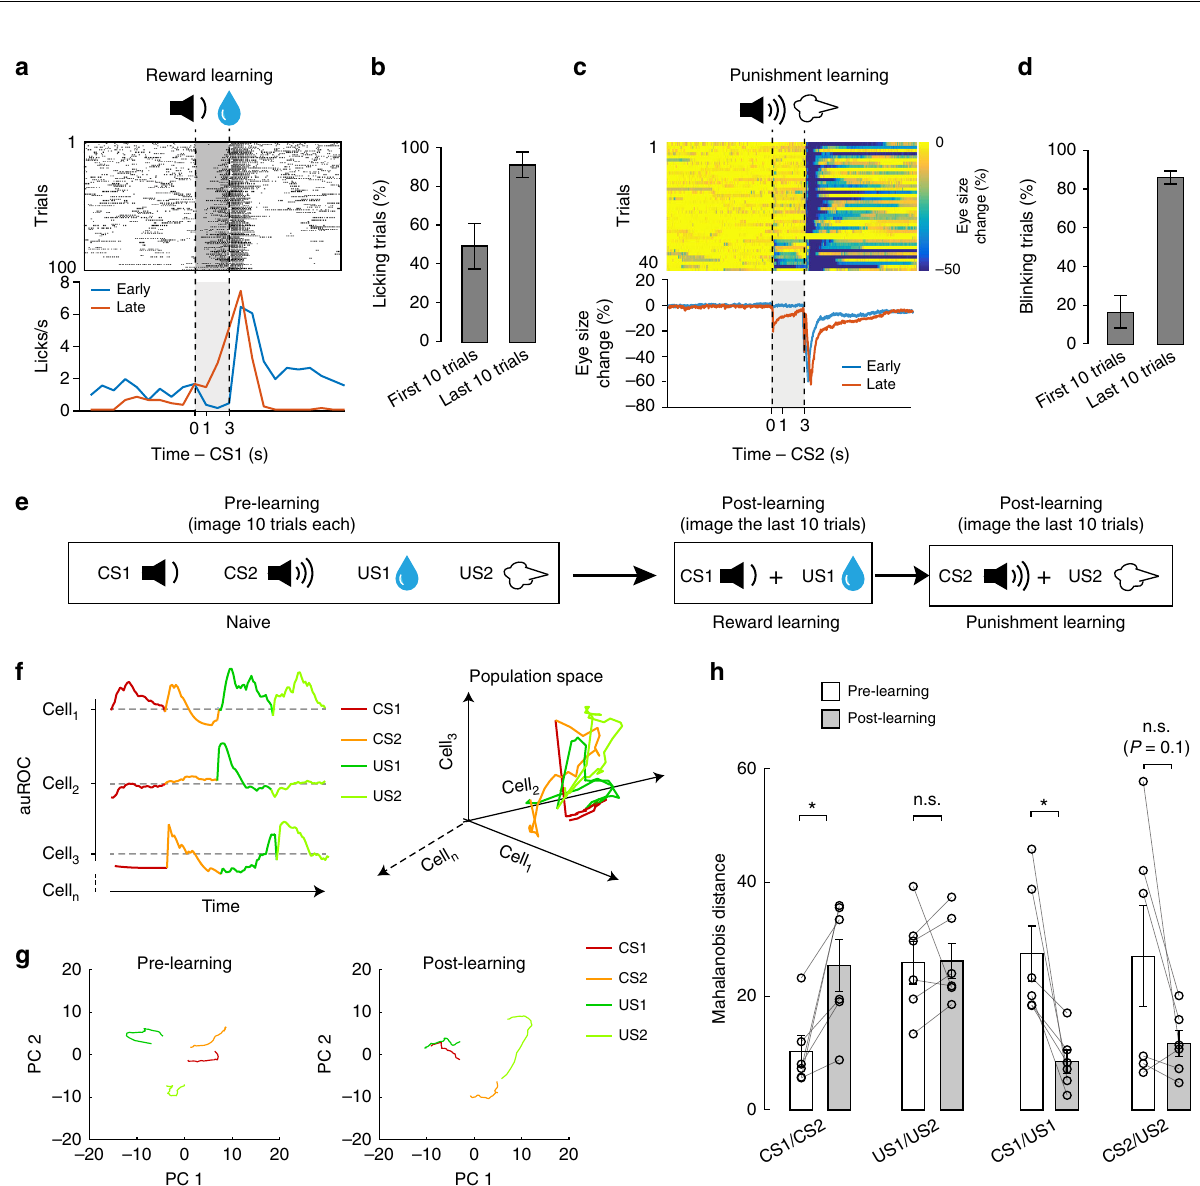
Fig. 7 Learning transforms CS representations in the BLA. a Changes in licking during the reward learning for a representative mouse. Upper panel: raster plot of licking events across trials. Bottom panel: average licking rate over time (1-s bin), plotted separately for early and late trials. Dashed lines indicate the onsets of CS1 (1 s duration) and US1 (water). Licks in the shaded area represent predictive licking events. b The percentage of trials in which mice showed predictive licking in the fi rst and last 10 trials ( n = 3 mice). c Changes in eye blinking during the punishment learning for the same mouse as that in ( a ). Upper panel: heat-maps of eye size changes across trials. Bottom panel: average eye size changes over time, plotted separately for early and late trials. Dashed lines indicate the onsets of CS2 (1 s duration) and US2 (air-puff). Eye blinks in the shaded area represent predictive blinking events. d The percentage of trials in which mice showed predictive blinking in the fi rst and last 10 trials ( n = 3 mice). e The timing of the imaging experiments relative to behavioral training. f Left: a schematic of the population vector analysis. The dynamic activities of a neuron (cell 1 – cell n for each mouse) during the 1 s time window immediately after the onset of each stimulus (CS1, CS2, US1, or US2) are represented by a vector, which is composed of sequential frame-by-frame z -scores computed for that neuron. Right: the trajectory of a population vector for three example neurons in a 3D space. g The BLA population activity from one representative mouse. The fi rst two principal components before (left) and after (right) learning are projected onto a 2D space. h Quanti fi cation of the Mahalanobis distances between vectors representing neuronal responses to different stimuli ( n = 6 mice; CS1/CS2, t (5) = − 3.25, * P = 0.022; US1/US2, t = − 0.07, P = 0.94 (n.s., nonsigni fi cant); CS1/US1, t = 3.29, * P = 0.021; CS2/US2, t = 2.01; P = 0.1; paired t- test). Data are presented as mean ± (5) (5) (5)